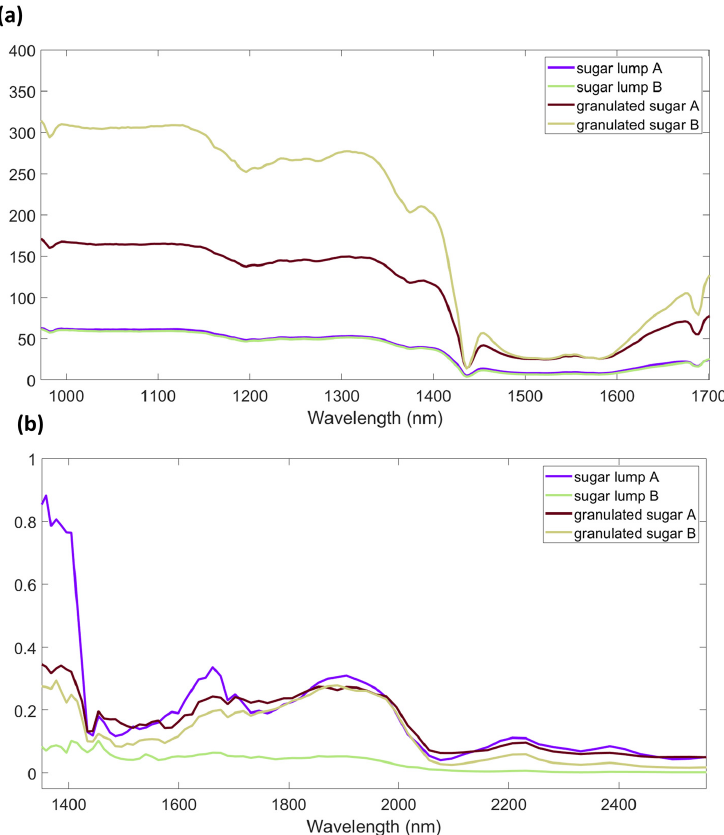
Figure 5. Diagonal of the Covariance Matrices calculated over background replicates spectra collect with ( a ) AvaSpec − Mini − NIR and ( b ) NeoSpectra Scanner. A stands for “background acquired before each sample”. B stands for “background acquired before each session”.